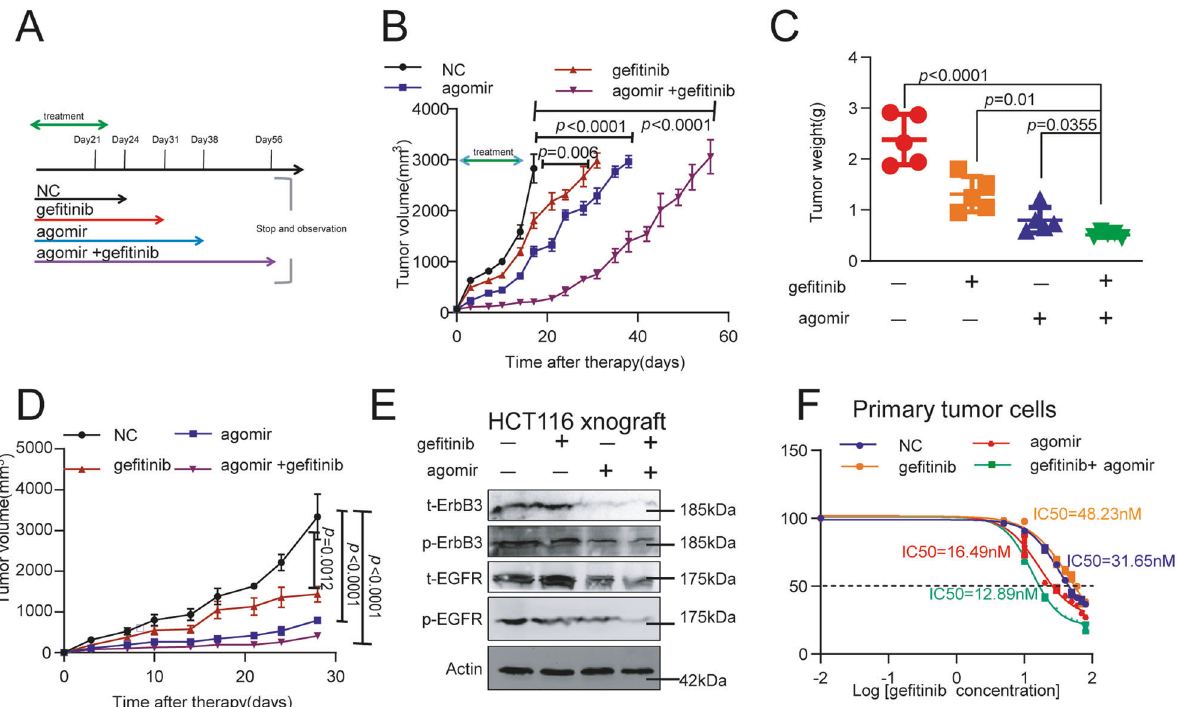
Fig. 6 MiR-323a-3p blocks acquired ge fi tinib resistance in a xenograft model. A Schematic diagram of the treatment model. B MiR-323a-3p inhibited subcutaneous tumors growth, combined with ge fi tinib ( n = 7). C MiR-323a-3p inhibited subcutaneous tumors weight, combined with ge fi tinib ( n = 5). D MiR-323a-3p inhibited subcutaneous tumors volume, combined with ge fi tinib ( n = 5). E MiR-323a-3p inhibited total and phosphorylated levels of EGFR and ErbB3 in subcutaneous tumor tissue samples, combined with ge fi tinib ( n = 5). F MiR-323a-3p blocked acquired ge fi tinib resistance in a xenograft model, the IC50 value was upregulated to 48.23 nM from 31.65 nM in the primary culture from ge fi tinib treated subcutaneous tumors, and the IC50 value was down-regulated to 12.89 nM in the primary culture from miR-323a-3p/ge fi tinib co-treated subcutaneous